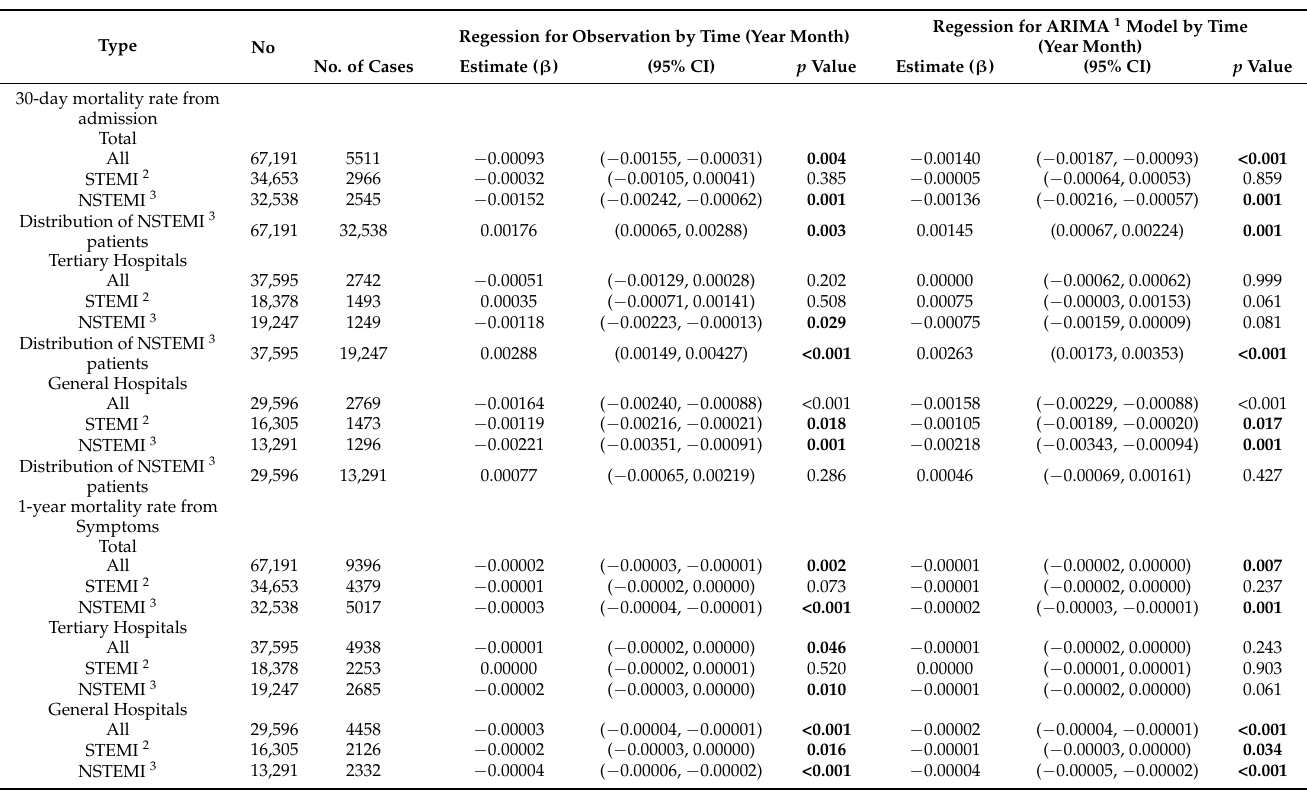
Table 3. Linear regression analysis of factors associated with mortality rate (2009 to